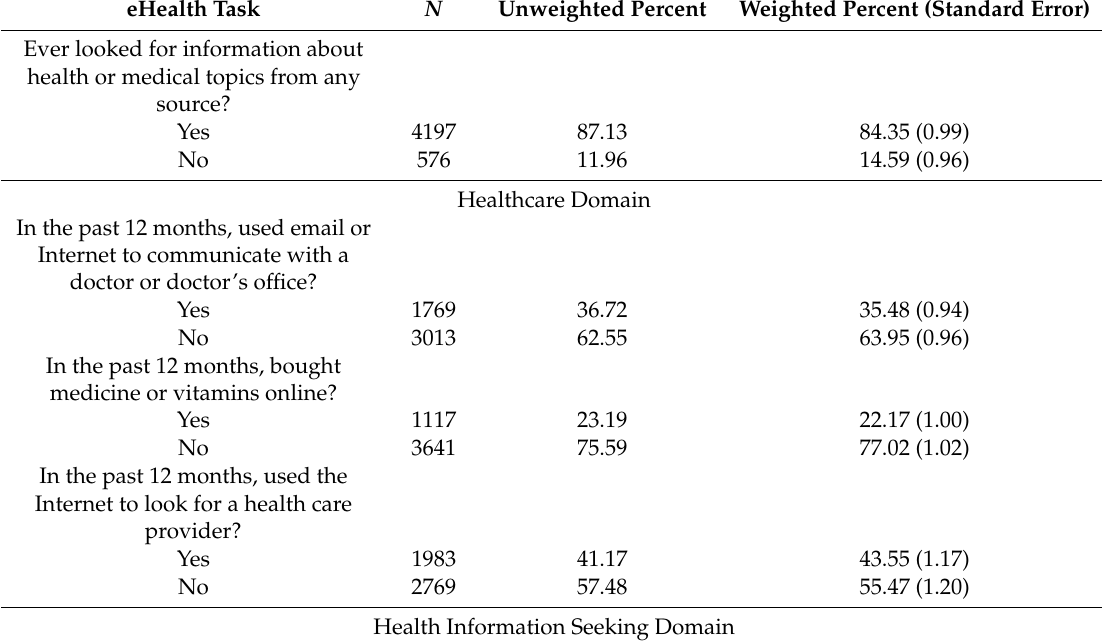
Table 2. Frequency and percent of eHealth tasks among HINTS participants. eHealth Task N Unweighted Percent Weighted Percent (Standard